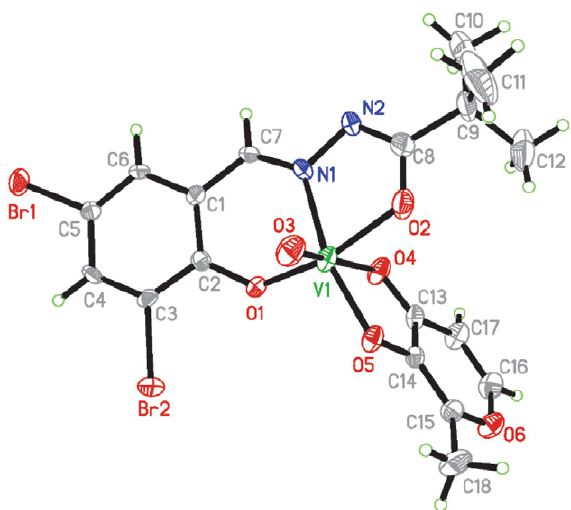
Fig. 2. ORTEP diagram of complex 2 with 30% thermal ellipsoid.